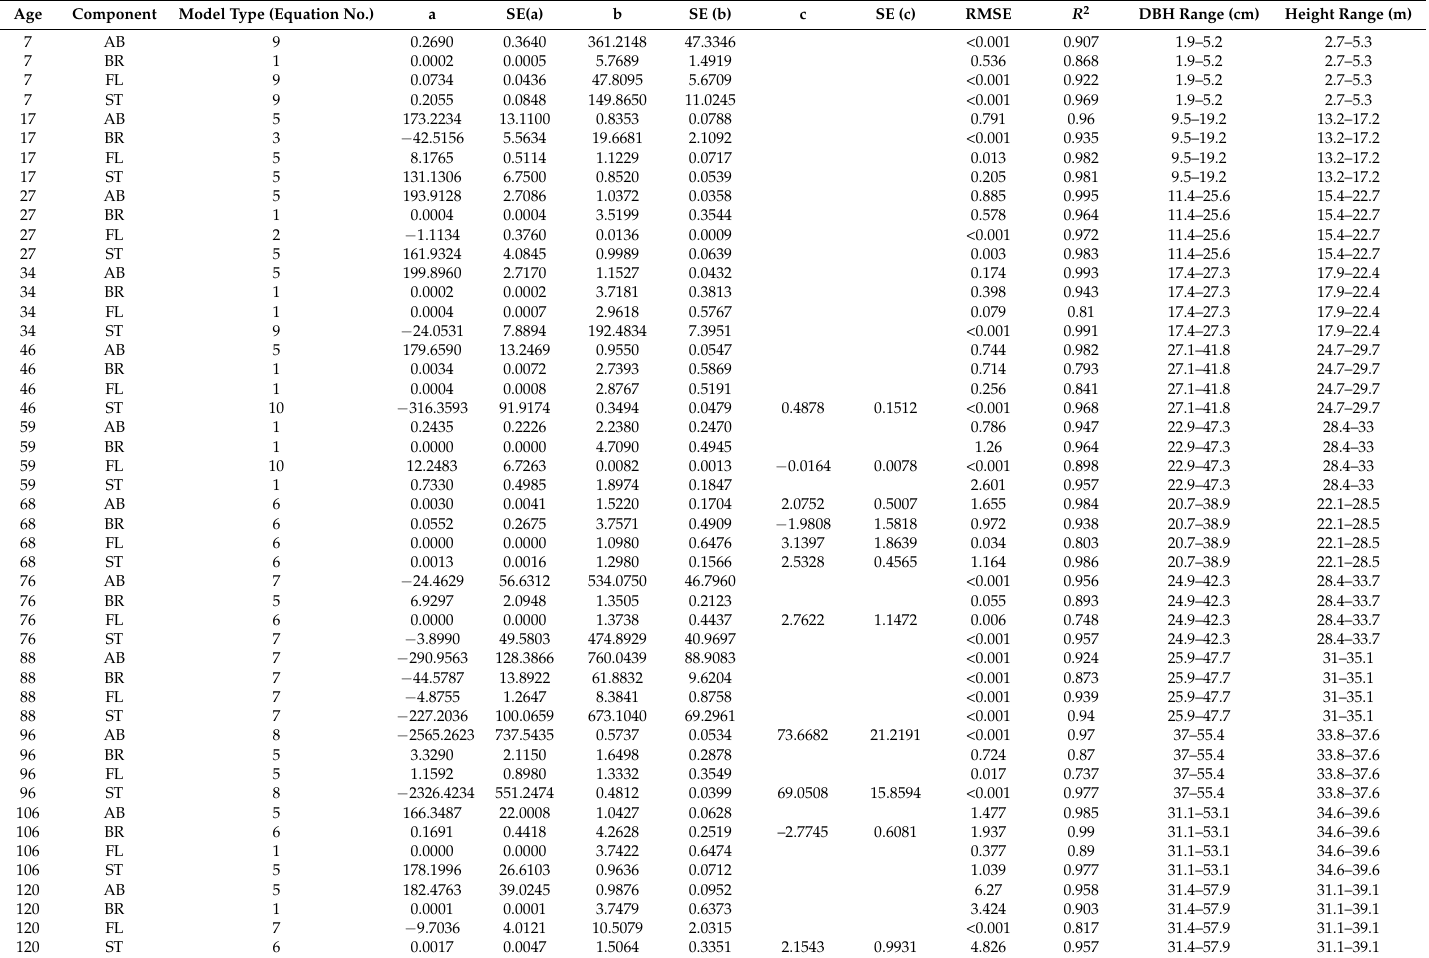
Table 2. Site-specific equations of biomass